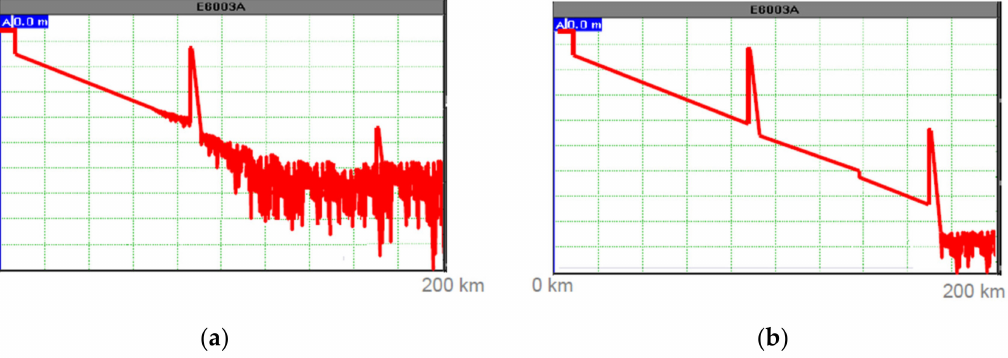
Figure 3. OTDR trace. ( a ) after 10 s averaging time, ( b ) after 3 min averaging